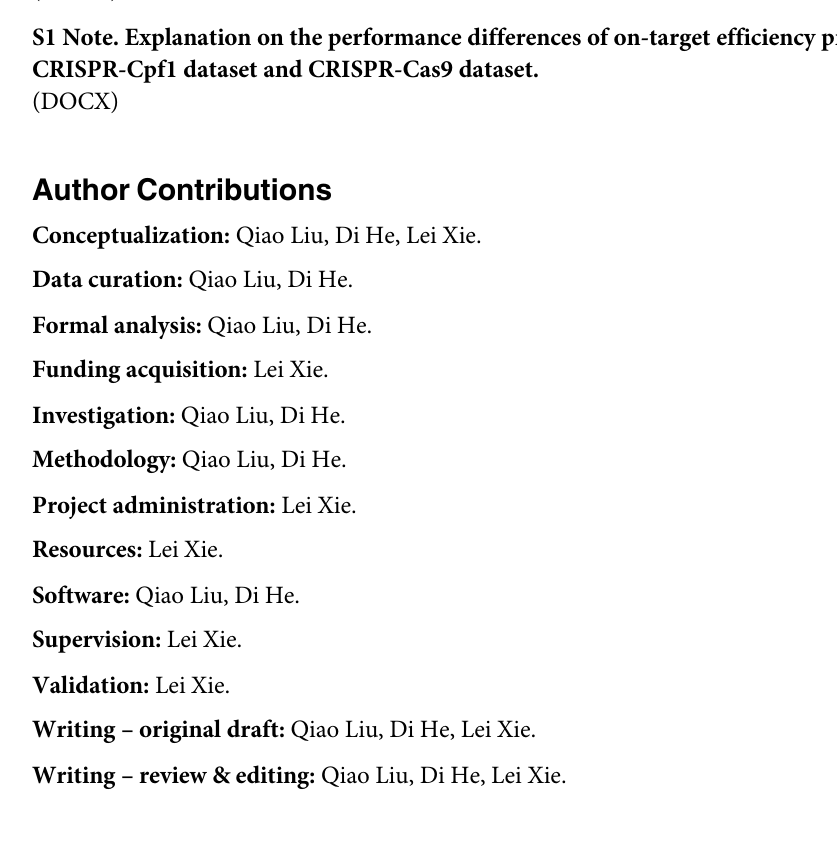
S1 Table. Comparison of models performance with Spearman correlation, Pearson’s corre- lation, and mean squared error (MSE) for on-target efficiency prediction of data in K562, A549, and NB4 cell lines. S2 Table. Performance comparison of AttnToCrispr_CNN with deepCRISPR. The test was performed following a 5-fold cross-validation procedure. S3 Table. Model performances of positive experiment data in HEK293T cell line with 5-fold cross-validation. S4 Table. Performance comparison of models with more cell-specific features and without these features for on-target efficiency prediction of data in K562, A549, and NB4 cell lines. These cell-specific features include DNase-seq, Chip-seq for CTCF, and H3K4me3 and RRBS data. S5 Table. Hyperparameters of each component in the implemented models. S1 Note. Explanation on the performance differences of on-target efficiency predictions of CRISPR-Cpf1 dataset and CRISPR-Cas9